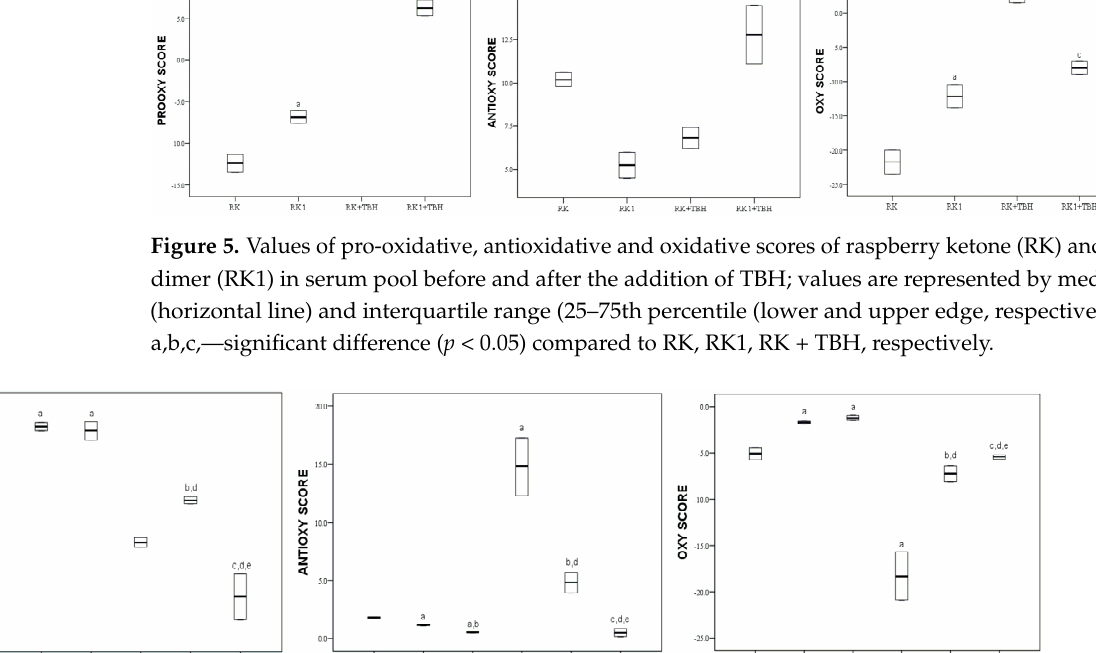
Figure 5. Values of pro-oxidative, antioxidative and oxidative scores of raspberry ketone (RK) and its dimer (RK1) in serum pool before and after the addition of TBH; values are represented by me- dian (horizontal line) and interquartile range (25–75th percentile (lower and upper edge, respec-